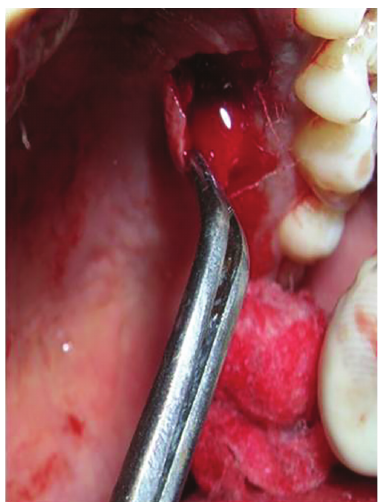
Figure 6: Donor site in the palate used for harvesting the subepithe- lial connective tissue graft.